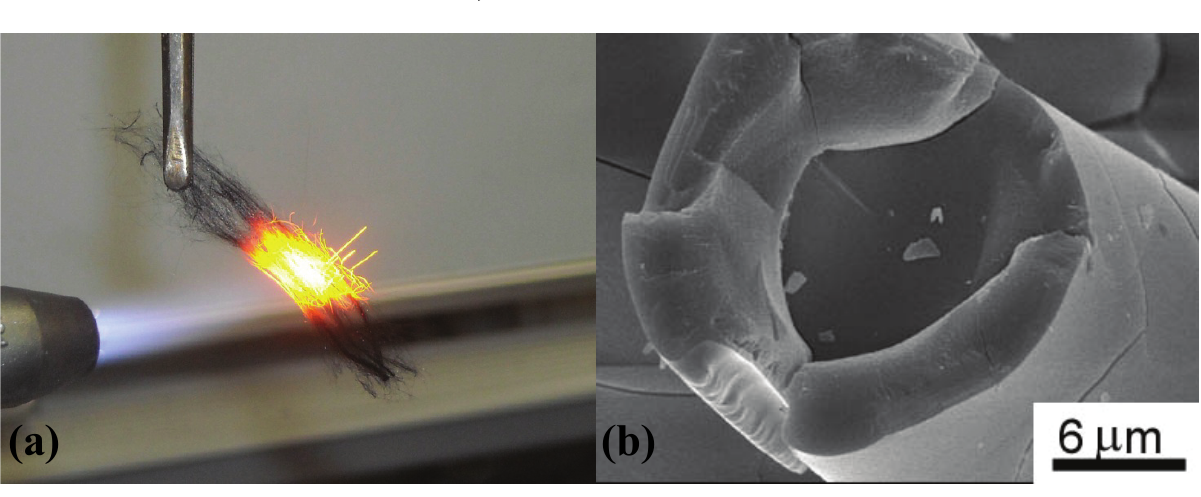
Figure 4. (a) Results of TG analysis on YR3370 TM resin in carbon rich atmosphere (10 K/min up to 1473 K, 3 K/min beyond 1473 K and holding at 1873 K for 3 h)